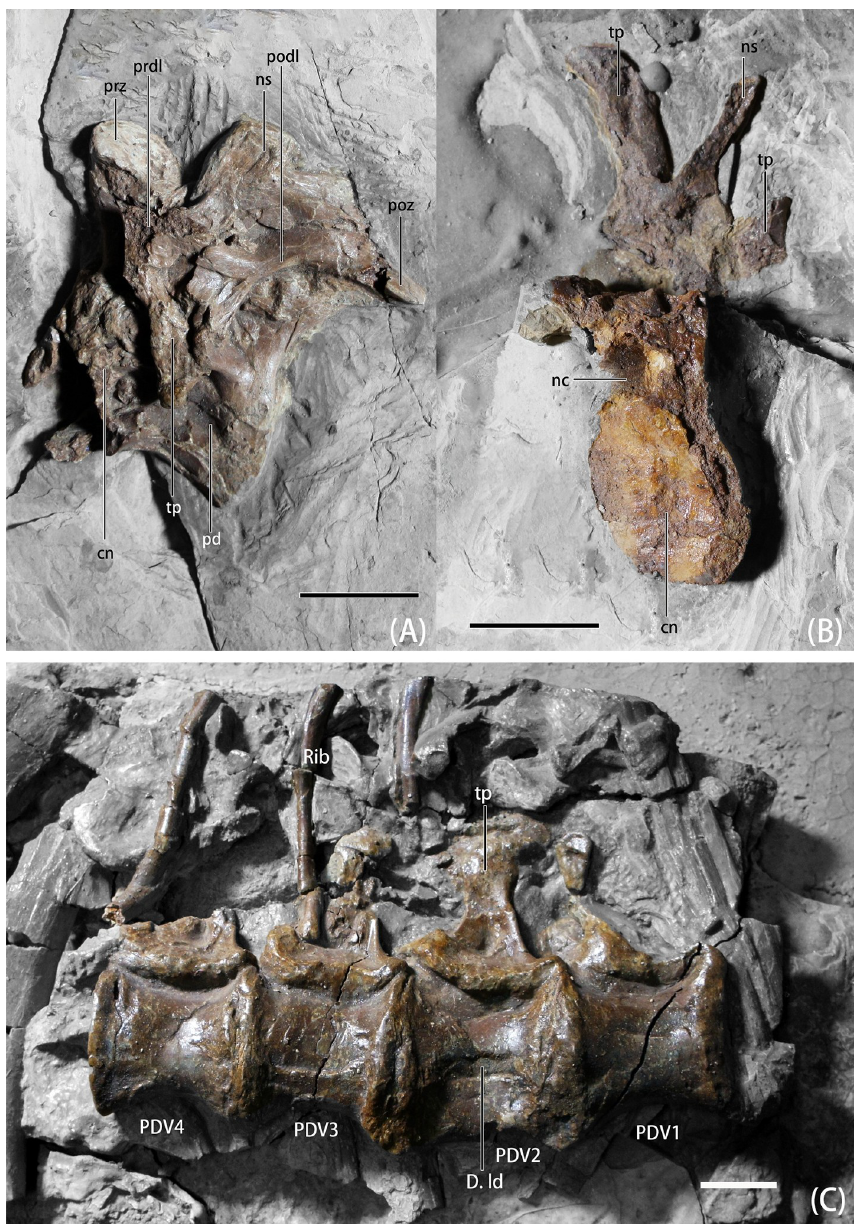
Fig 2. Photographs of the dorsal vertebrae of B . inexpectus (IVPP V 11559) A. antero-middle dorsal in lateral view; B. middle dorsal in anterolateral view; C. posterior dorsals in lateral view. Abbreviations: cn , centrum; D. ld , lateral depression of dorsals; nc , neural canal; ns , neural spine; pd, pneumatic depression; PDV1-4, posterior dorsal vertebrae 1–4; podl , postzygadiapophyseal lamina; poz , postzygapophyses; prdl , prezygadiapophyseal lamina; prz , prezygapophyses; tp , transverse process. Scale bars equal 2